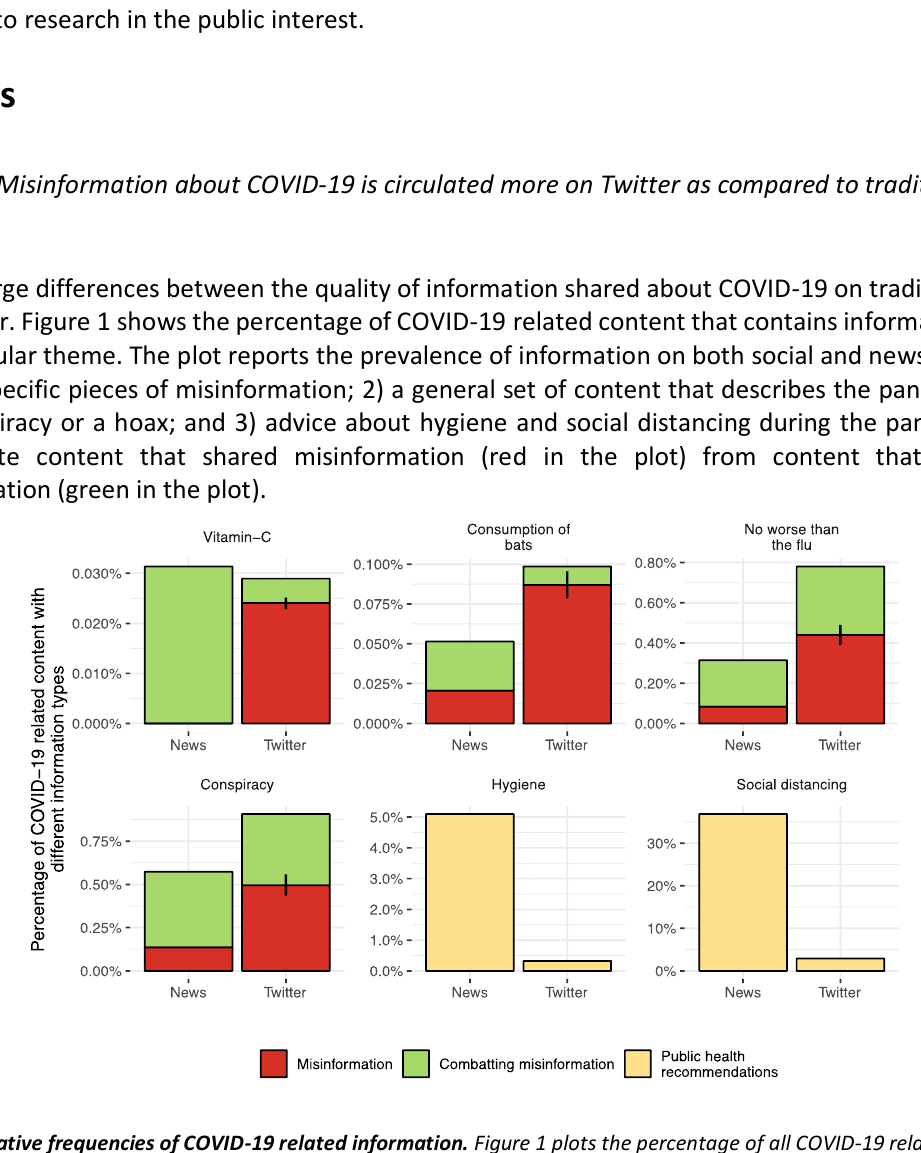
Figure 1. Relative frequencies of COVID-19 related information. Figure 1 plots the percentage of all COVID-19 related content that includes reference to a particular theme. Confidence intervals are shown only for the tweets where a random sample was manually categorized and the results extrapolated to all tweets in the